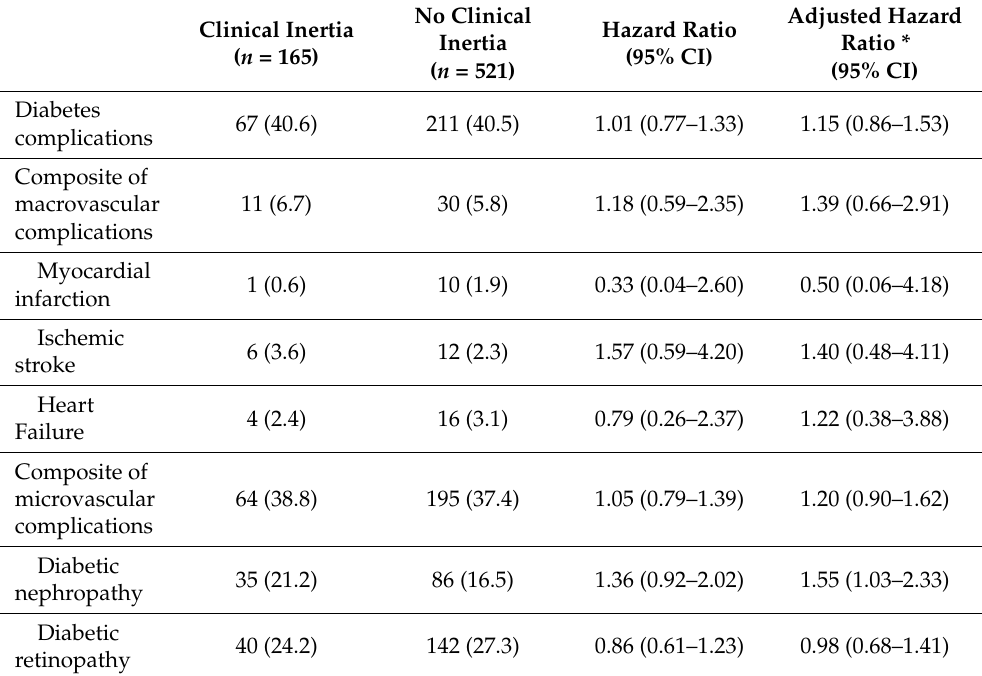
Table A1. Hazard ratios showing the effect of clinical inertia on diabetes complications by propensity score covariate adjustment analysis ( n = 686).